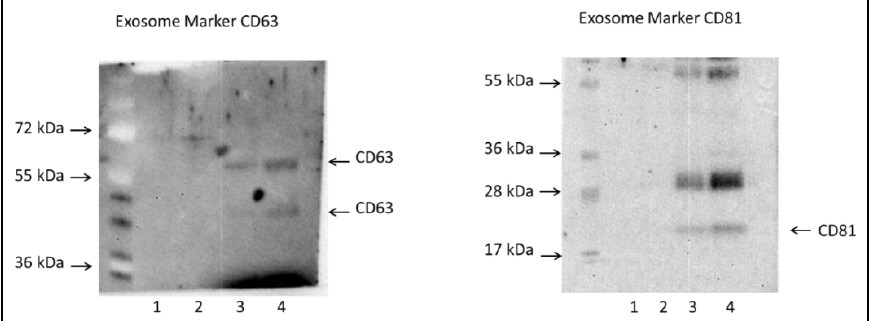
Figure 1. Western Blot, only septic patient samples shown.